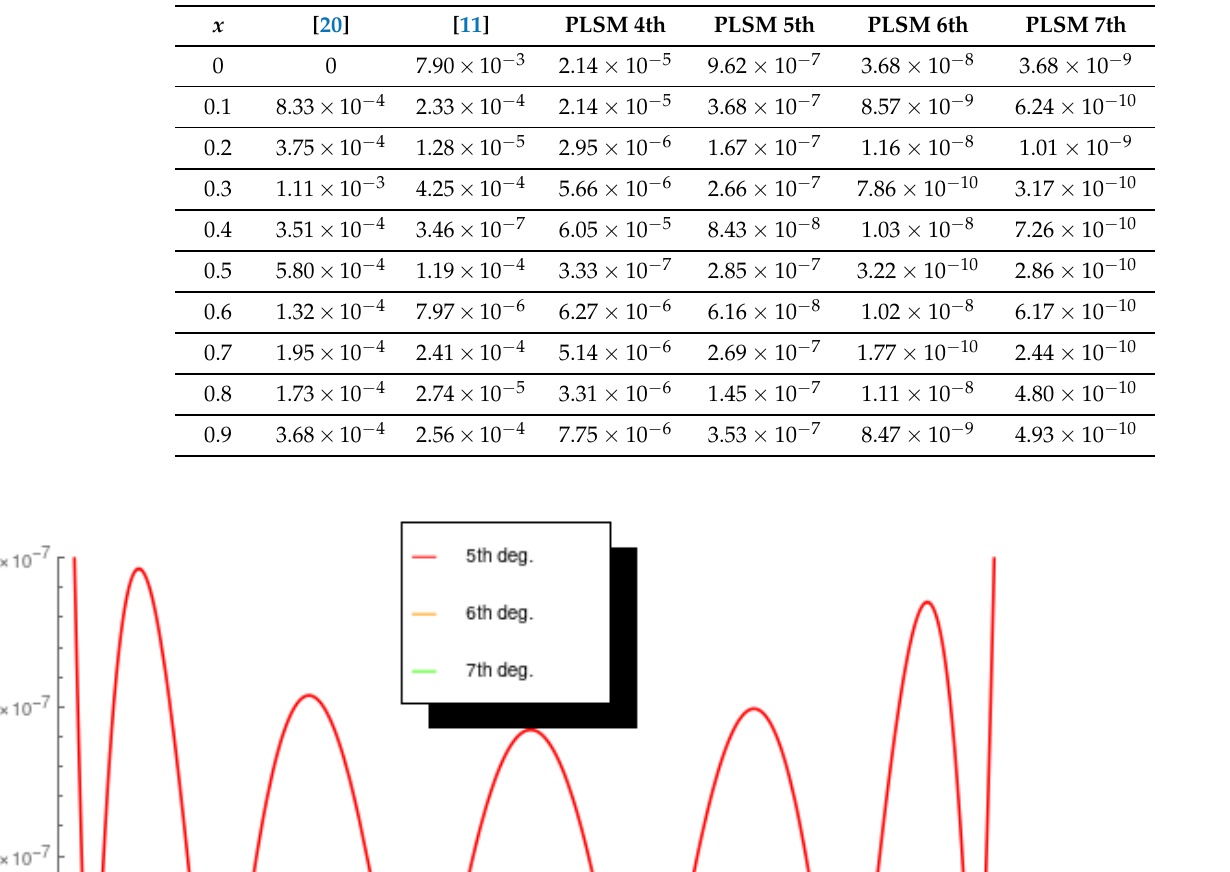
Table 3. Absolute errors of the approximations for problem (15).